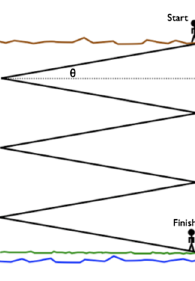
FIG. 9. Diagram and problem text of problem P4.